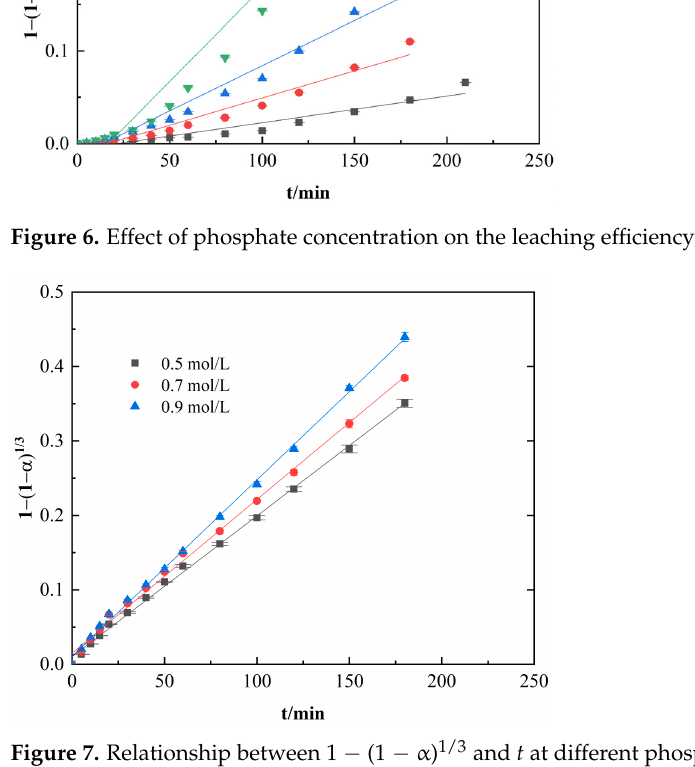
Figure 7. Relationship between 1 − (1 − α ) 1/3 and t at different phosphate concentrations.